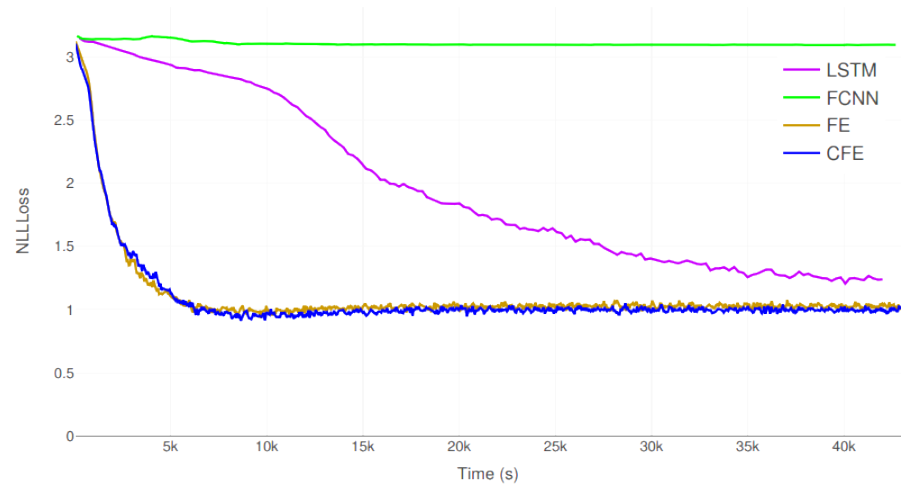
Figure 10. Evolution of the validation error (NLLLoss) during training of the four models on E2. Table 7. p -Values of the second experiment (E2), indicating the probability of the null hypothesis, i.e., the results of the models are not distinguishable. p -Value LSTM FCNN FE